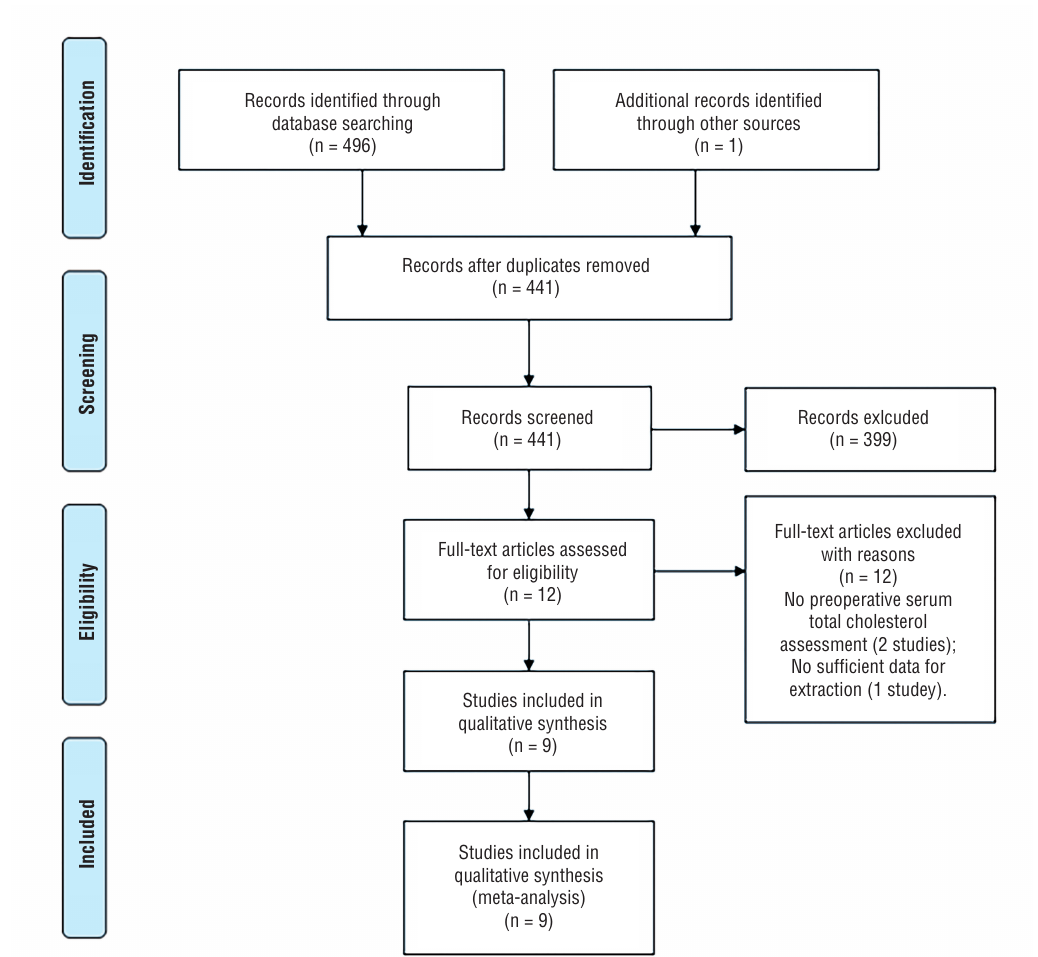
Figure 1 - Flow diagram of literature searches according to the Preferred Reporting Items for Systematic Reviews and Meta- Analyses